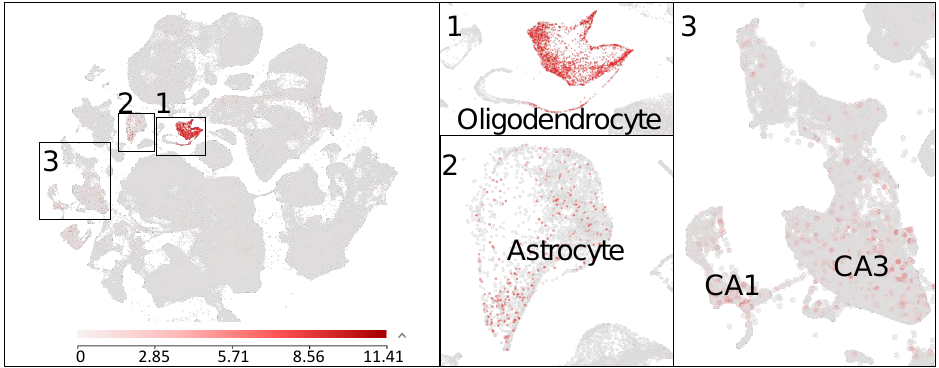
Figure 1. Single-cell RNAseq showing GPR37 expression in the mouse brain. A meta-analysis reveals GPR37 mRNA expression in oligodendrocytes (box 1), astrocytes (box 2), and hippocampal CA1 and CA3 neurons (box 3). The small boxes are enlarged in the middle and right panels. The data are plotted from the Allen brain map dataset (Mouse-Whole cortex & Hippocampus- 10X). (https://celltypes.brain-map.org/rnaseq/mouse_ctx-hpf_10x?selectedVisualization=Scatter+ Plot&colorByFeature=Gene+Expression&colorByFeatureValue=Gpr37, accessed on 21 October